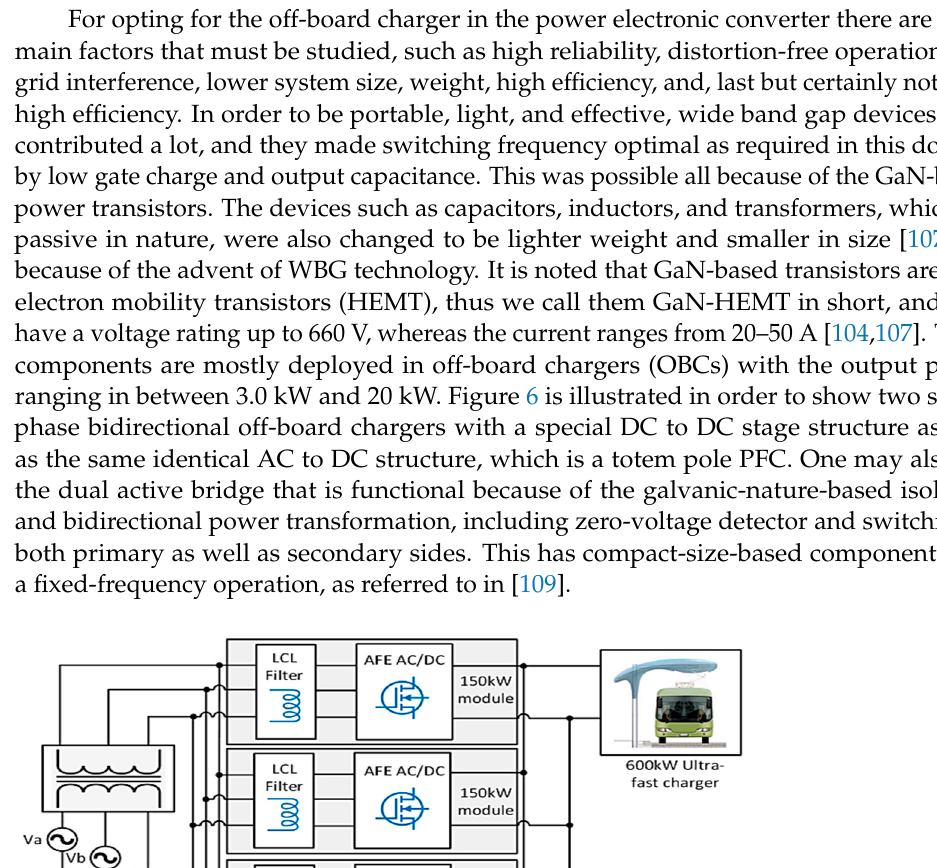
Figure 5. Architecture of the multiphase-bidirectional on-board charger system [107]. Bidirectional (V2G/G2V) On-Board Charging Systems